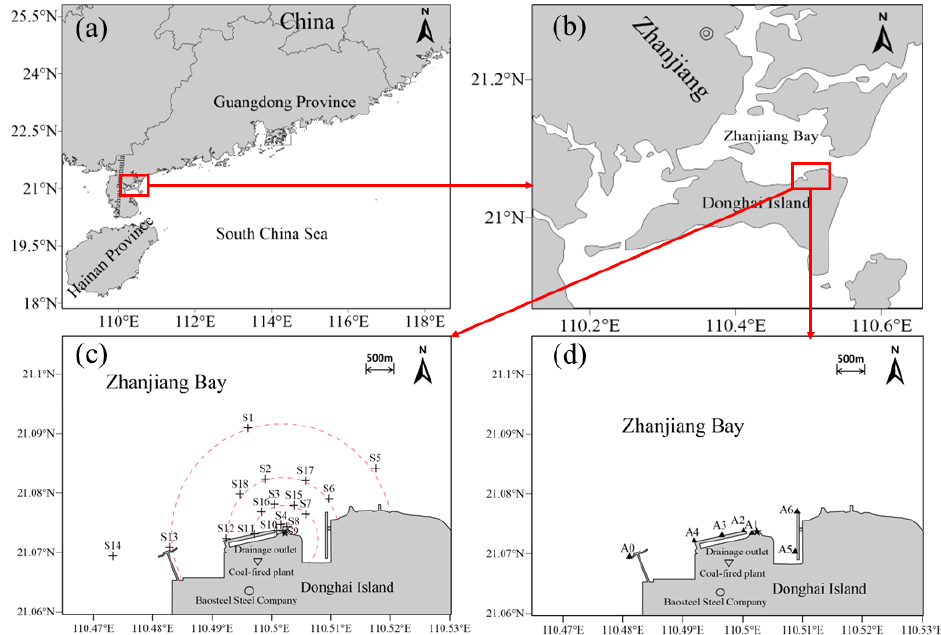
Figure 1. Survey station map. ( a ) Location of the survey area in mainland China. ( b ) Location of the survey area in Zhanjiang. ( c ) Seawater quality survey station. ( d ) Sampling stations of oysters and barnacles. Table 1. Distance from biofouling sampling stations to drainage outlet (m).